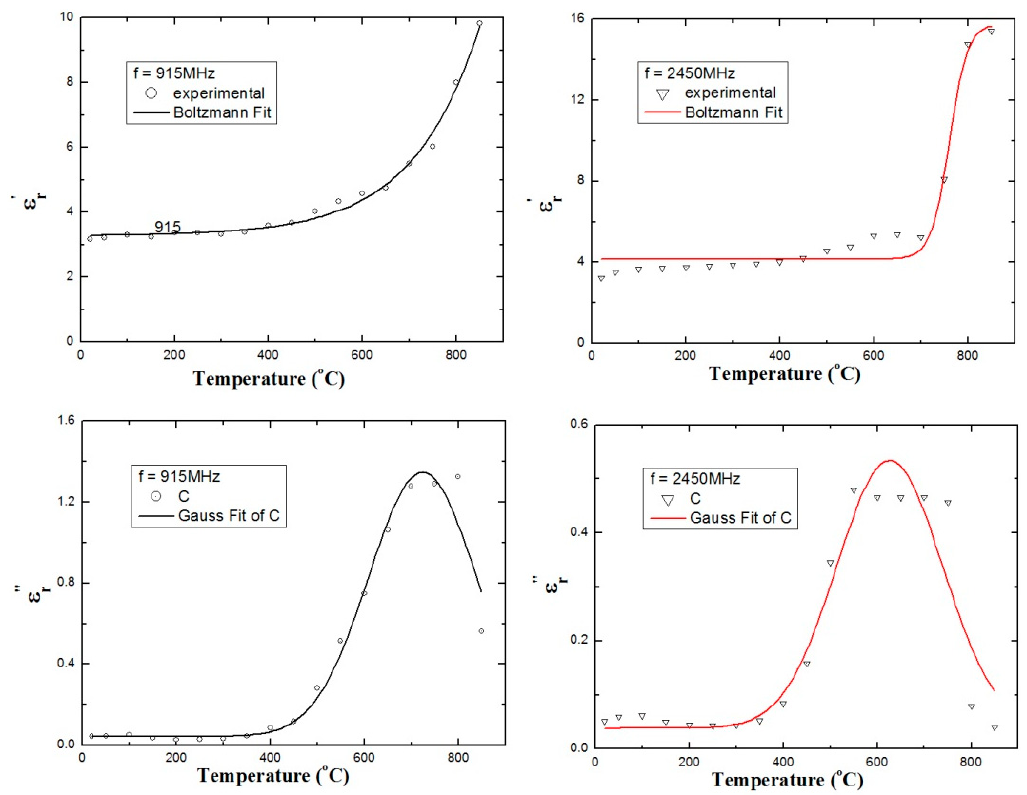
Figure 6. Experimental values of dielectric properties fitted with Boltzmann model and Gauss model for apparent density 1.63 g/cm 3 at 915 MHz and 2450 MHz.